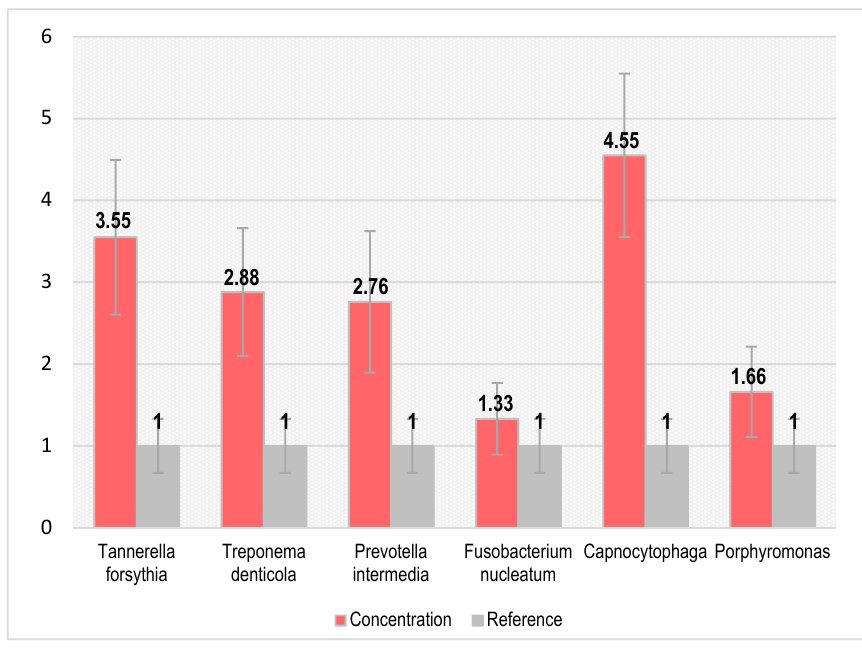
Figure 3. Concentration of bacteria type involved in periodontal pathology of study group.